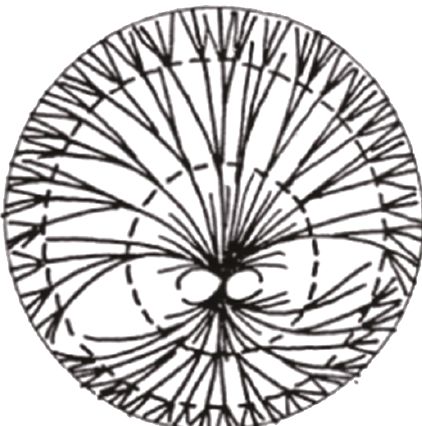
Figure 2: Biocrystallization method based on a phenomenon of dendritic pattern formation during crystallization from an aqueous solution containing plant extracts and CuCl 2